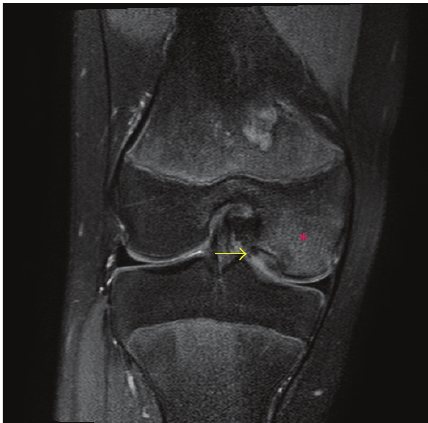
Figure 2: A 13-year-3-month-old female with FOPE zones at both proximal tibiae. Findings: coronal proton density fat-saturated image from right knee MRI obtained 9 months after initial presenta- tion shows an osteochondral lesion (arrow) with mild surrounding marrowedema (asterisk)of the medial femoral condyle correspond- ing to subtle lytic lesion present on initial radiographs. Technique: coronal PD fat-saturated MRI (TR = 2,825.7, TE = 30), ST = 2.5 mm, spacing = 3.264 mm, FOV = 14cm, and matrix = 312 × 244.